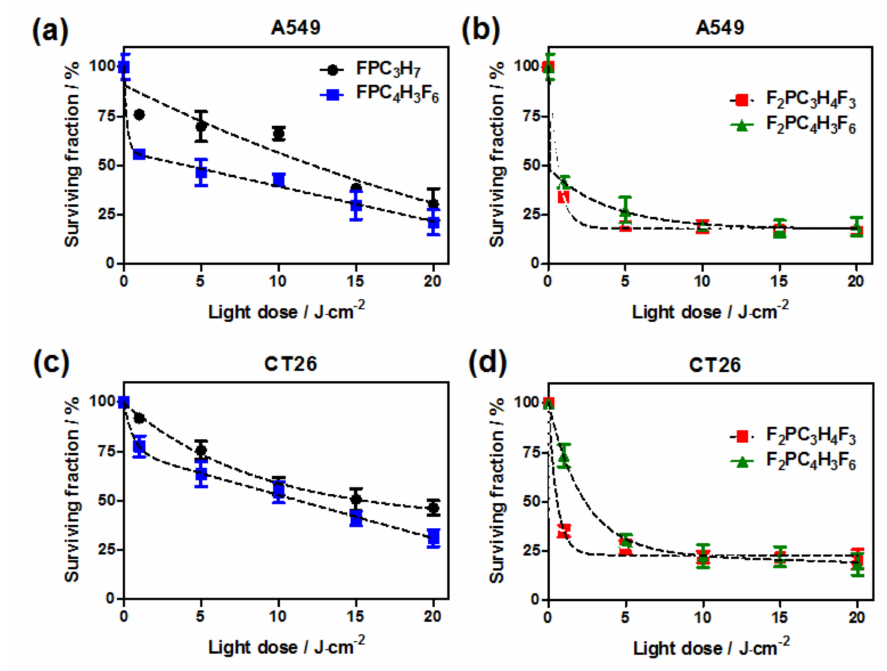
Figure 8. Survival fraction of A549 ( a , b ) and CT26 ( c , d ) cells in the presence of sulfonate ester porphyrins as a function of applied red-light doses. The data shown are the means ± SEM of three independent